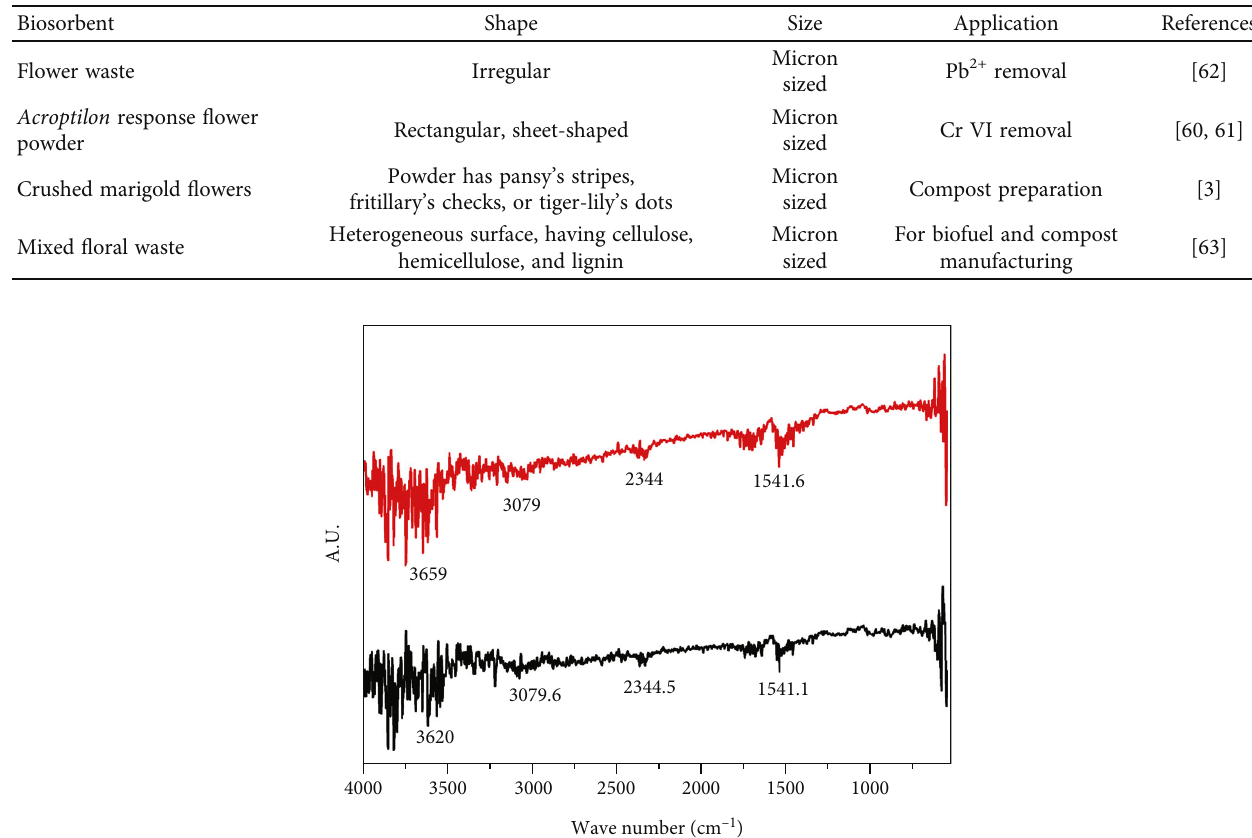
Table 1: Comparative morphological and elemental studies of fl oral bioadsorbent by FESEM.